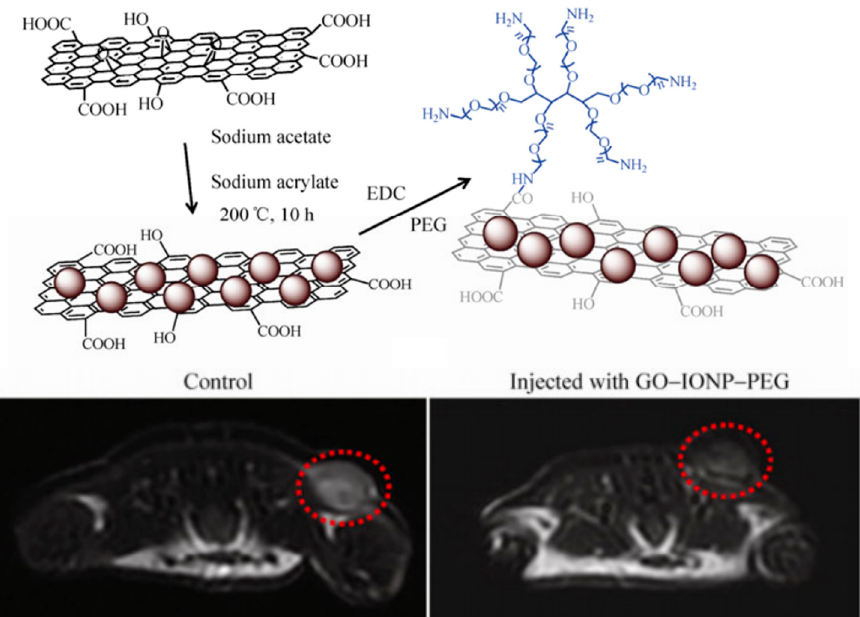
Figure 5. Iron oxide nanocrystal-modified graphene oxide nanoparticle (GO-IONP) synthesis and application as theranostic agent. The graphene oxide acted as an effective photothermal absorber while the iron oxide nanocrystals could simultaneously act as a contrast agent in MRI imaging. Reproduced with permission from [45]; Copyright © 2012 Springer Nature.